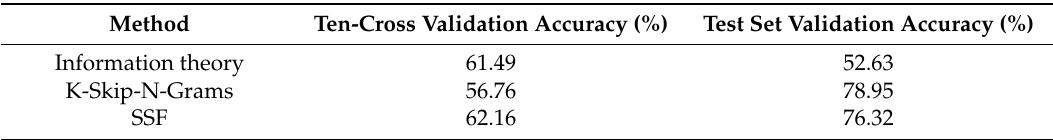
Table 4. The PDB186 is classified by a random forest and single feature